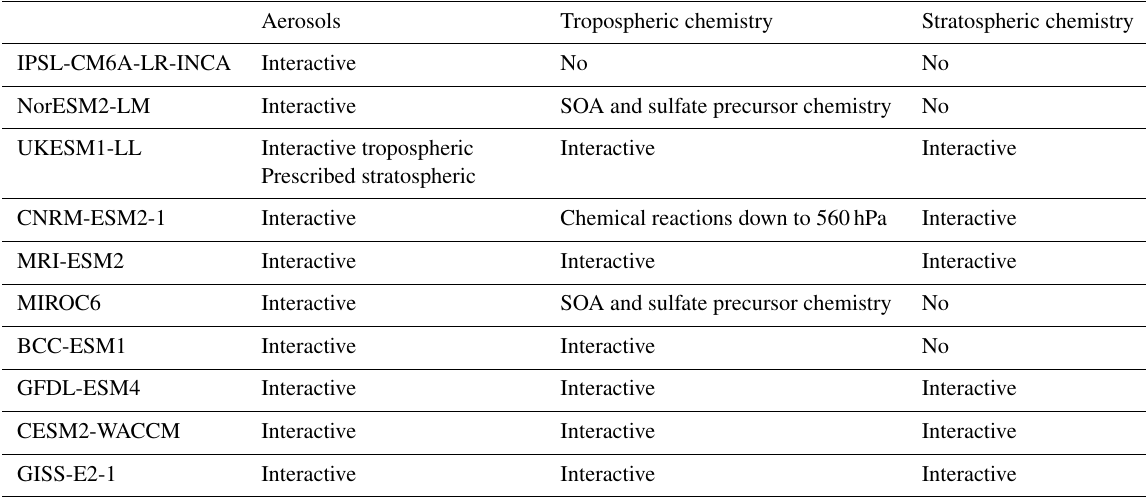
Table 1. Components used in the Earth system models (a detailed table is in the Supplement, Table S1). Aerosols Tropospheric chemistry Stratospheric chemistry IPSL-CM6A-LR-INCA Interactive No No NorESM2-LM Interactive SOA and sulfate precursor chemistry No UKESM1-LL Interactive tropospheric Interactive Interactive Prescribed stratospheric CNRM-ESM2-1 Interactive Chemical reactions down to 560hPa Interactive MRI-ESM2 Interactive Interactive Interactive MIROC6 Interactive SOA and sulfate precursor chemistry No BCC-ESM1 Interactive Interactive No GFDL-ESM4 Interactive Interactive Interactive CESM2-WACCM Interactive Interactive Interactive GISS-E2-1 Interactive Interactive